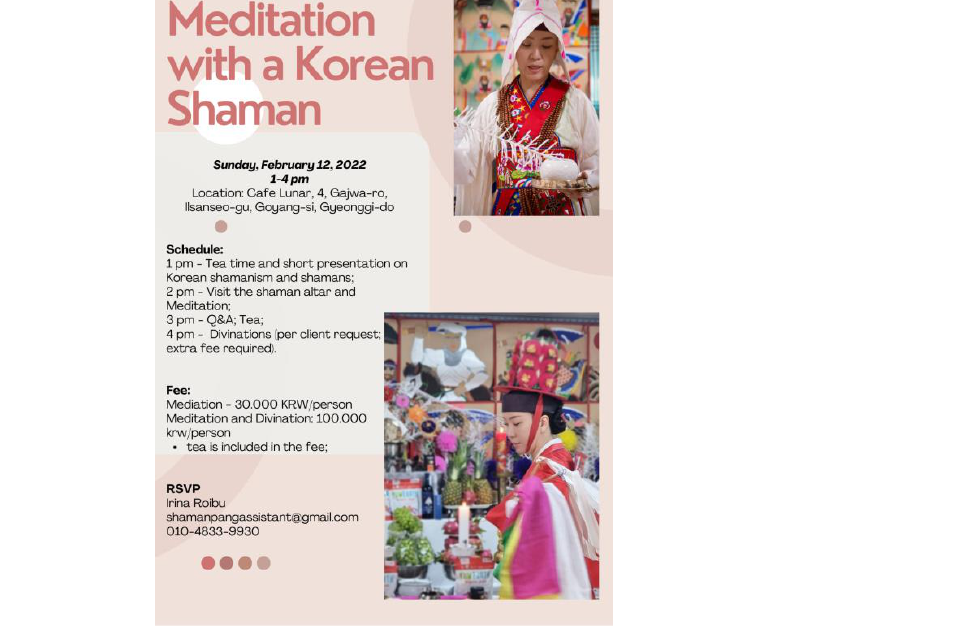
Figure 5. Mudang Pang’s invitation for foreigners to meditate. January 2023, the photograph is published with authorization from Pang Ŭn-mi.